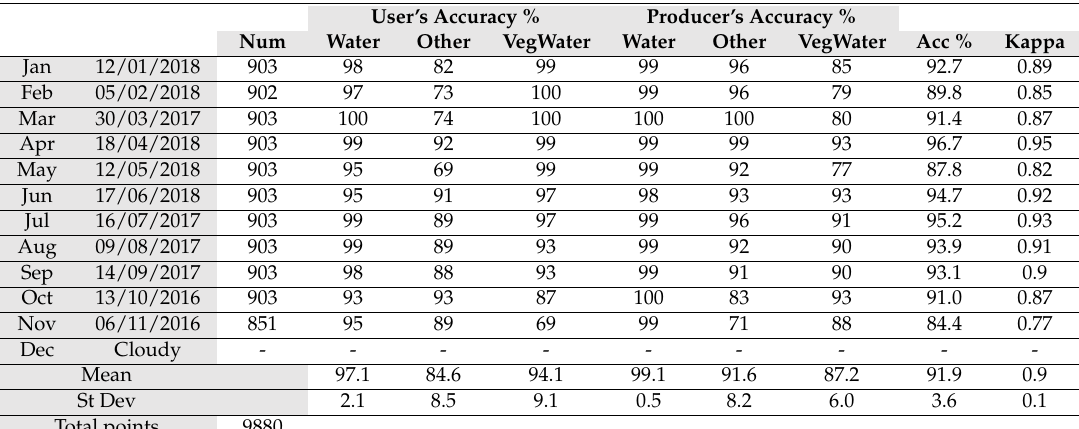
Table 2. Summary of the accuracy assessment